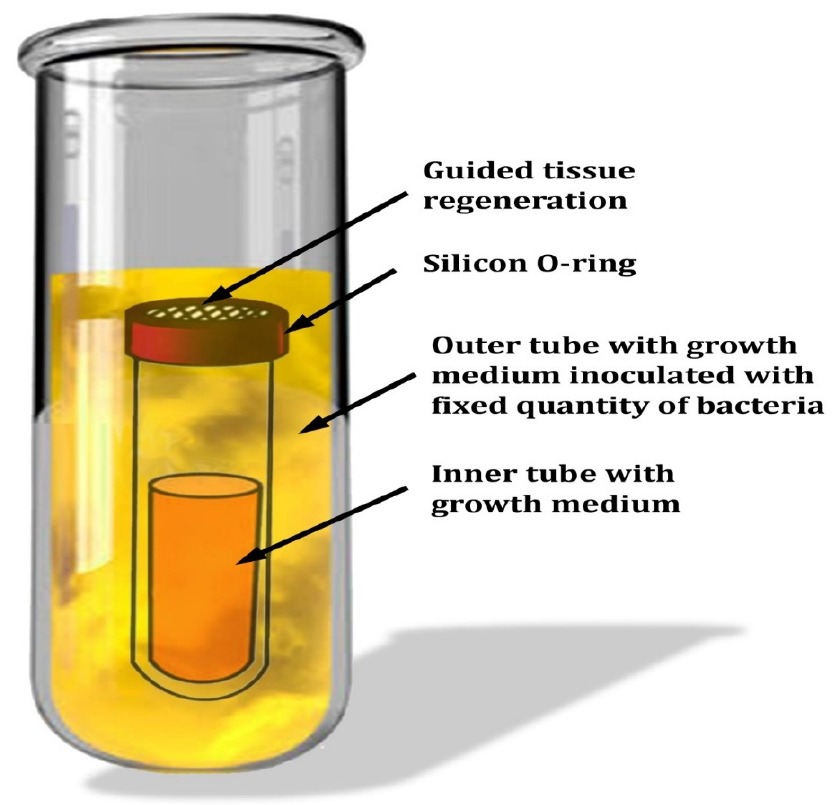
Figure 1. Schematic representation of the in vitro experimental setup for the permeability test of bacteria. of